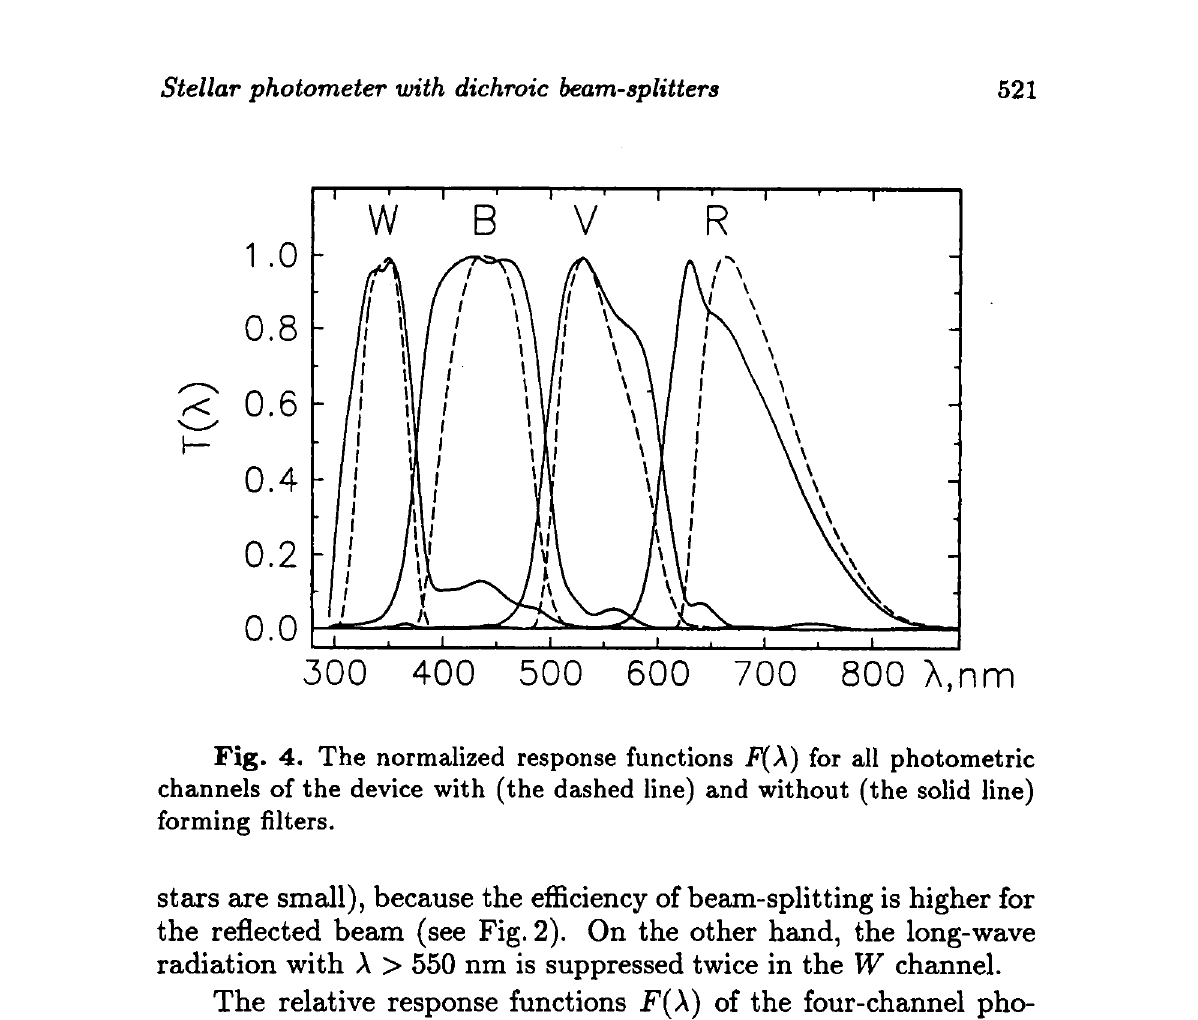
Fig. 4. The normalized response functions F( A) for all photometric channels of the device with (the dashed line) and without (the solid line) forming